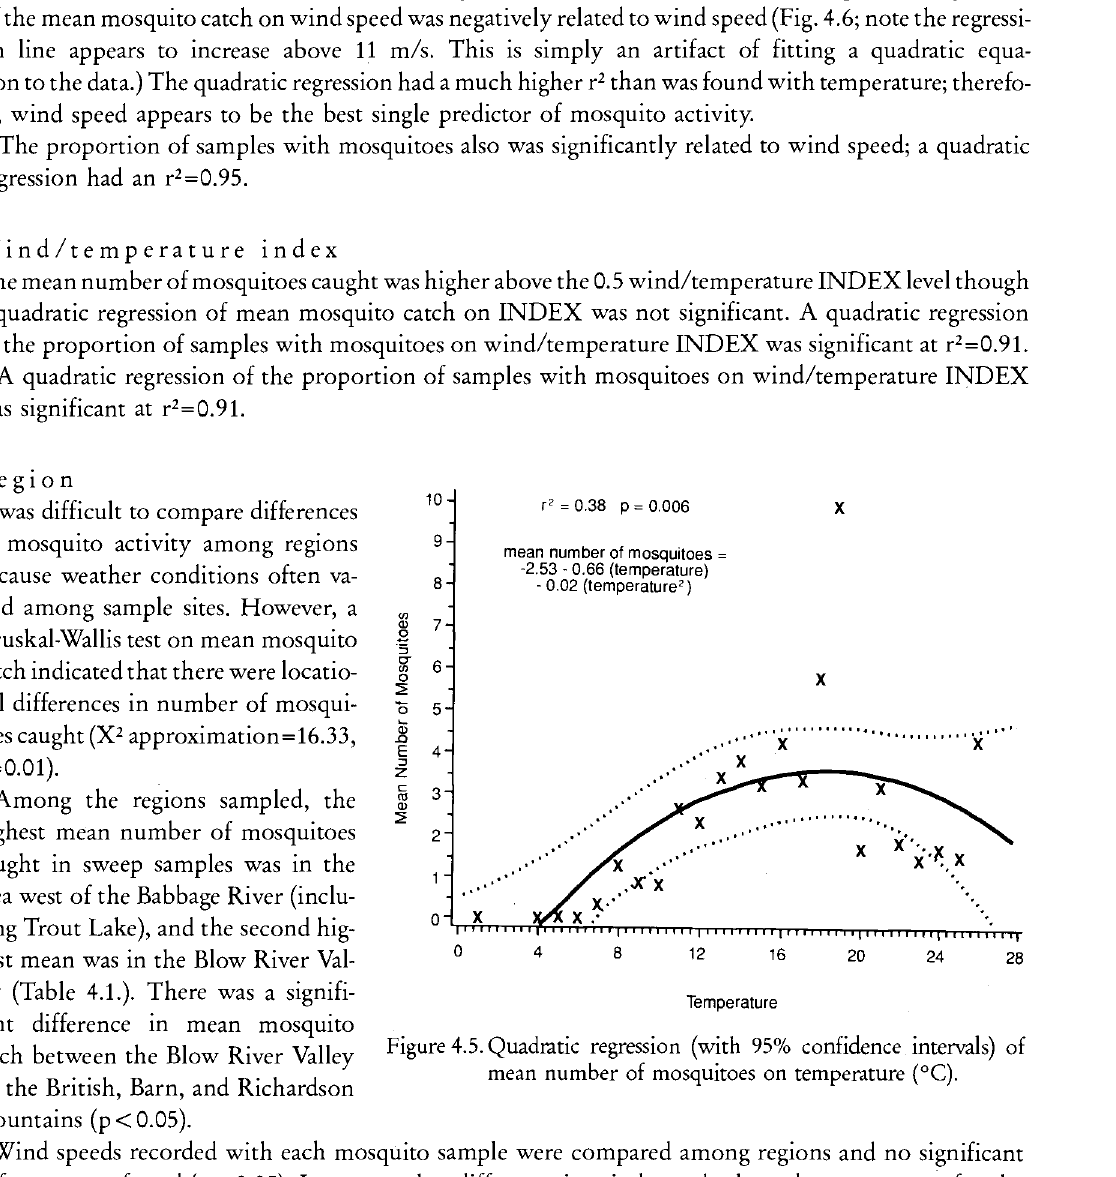
Figure 4.5. Quadratic regression (with 95% confidence intervals) of mean number of mosquitoes on temperature